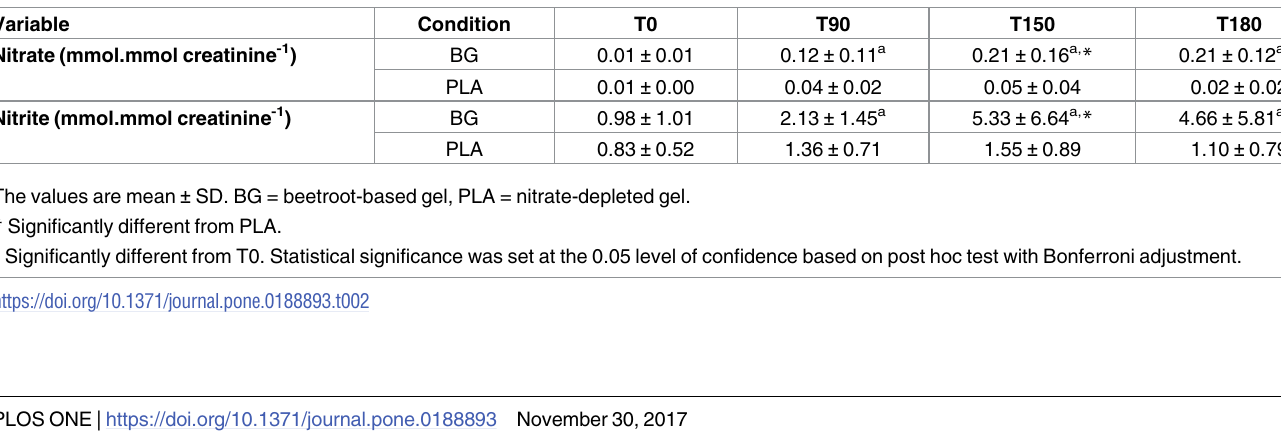
Therefore, a non-parametric test was used for statistical analysis of these variables. Sphericity was violated for urinary nitrate and nitrate. For all other variables, the assumptions of normal- ity, homogeneity of variances and sphericity were not violated. The plot of each residuals anal- ysis of SmO and tHb during exercise and recovery period for both BG and PLA conditions 2 was included as Supplementary Materials (S1 File). twelve (three men and nine women) (46%) completed the study. Among the 14 participants that declined (54%), eleven participants withdrew for personal reasons and three participants withdrew due to illness unrelated to the study. Among the personal reasons, the discomfort of the exercise protocol and the duration of each experimental procedure visit (which lasted approximately 4 hours each) were the most stated by the participants who declined. The base- line volunteers’ characteristics are shown in Table 1.